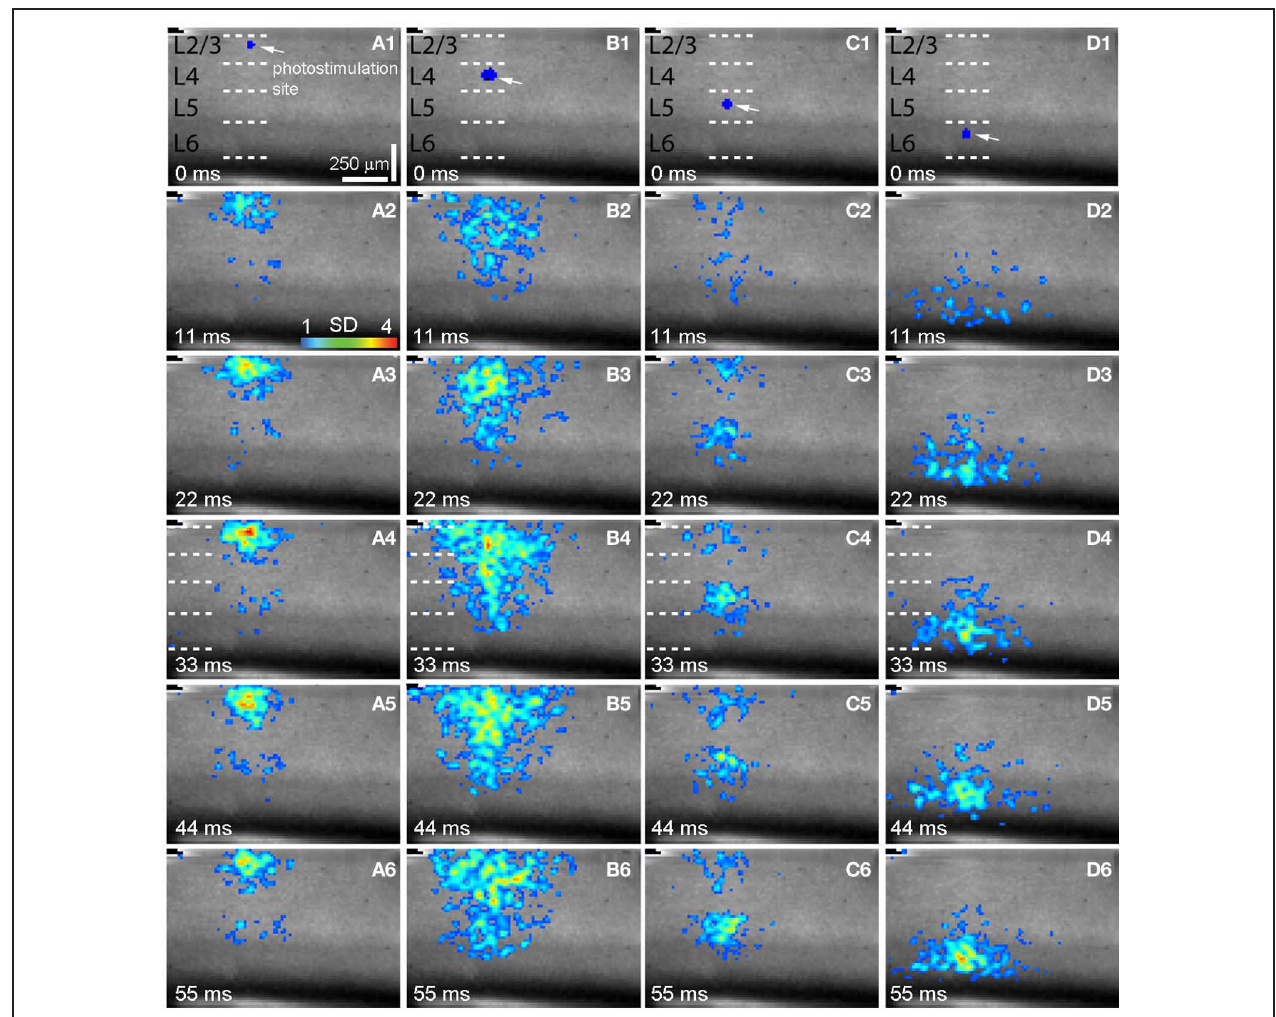
FIGURE 2 | Spatiotemporal distribution of photostimulation-evoked VSD responses across V1 laminar circuits. (A–D) are time series data of imaging photostimulation-evoked responses at V1 cortical layers 2/3, 4, 5, and 6 (i.e., sites 2, 6 10, 14 of the same slice as shown in Figure 1A ), respectively. VSD images were acquired at the rate of 2.2ms/frame during the experiment and are displayed at the specified time points. Time